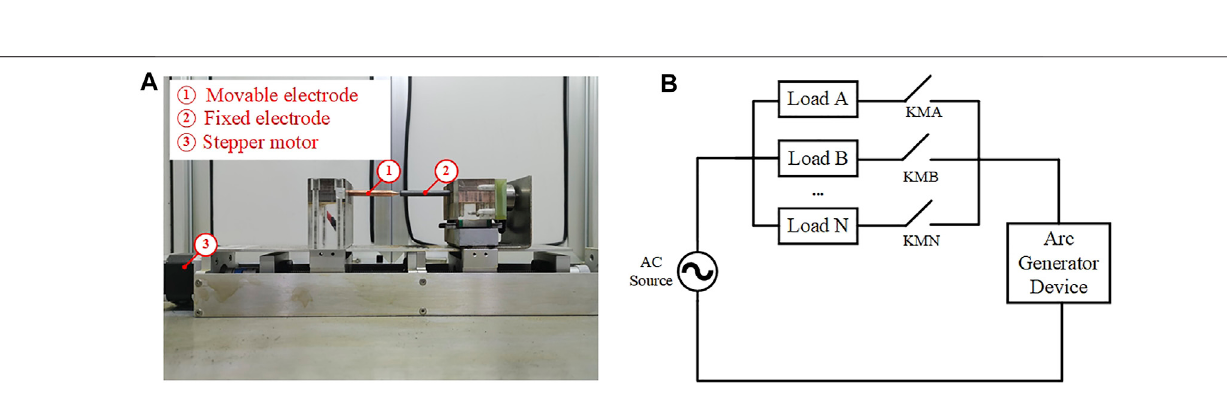
FIGURE 6 | MHD simulation results. (A) Arc voltage under different electrode gaps and currents; (B) transient arc voltage under different spacing.